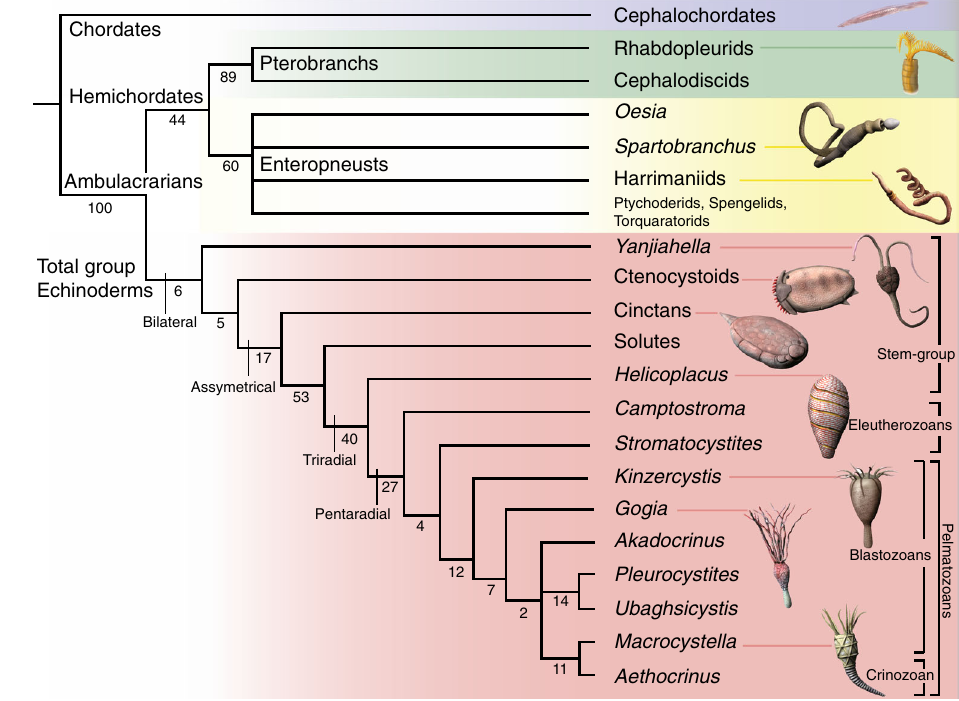
Fig. 3 Phylogenetic position of Yanjiahella biscarpa within the Ambulacraria. Topology based on implicit enumeration with autocollapse search off and resampling via standard bootstrap methods. Bootstrap values shown under each node. Fifteen trees were found with a total length of 71 steps (Consistency Index = 0.648, Rentention Index = 0.821). Taxa illustrated by Nobumichi